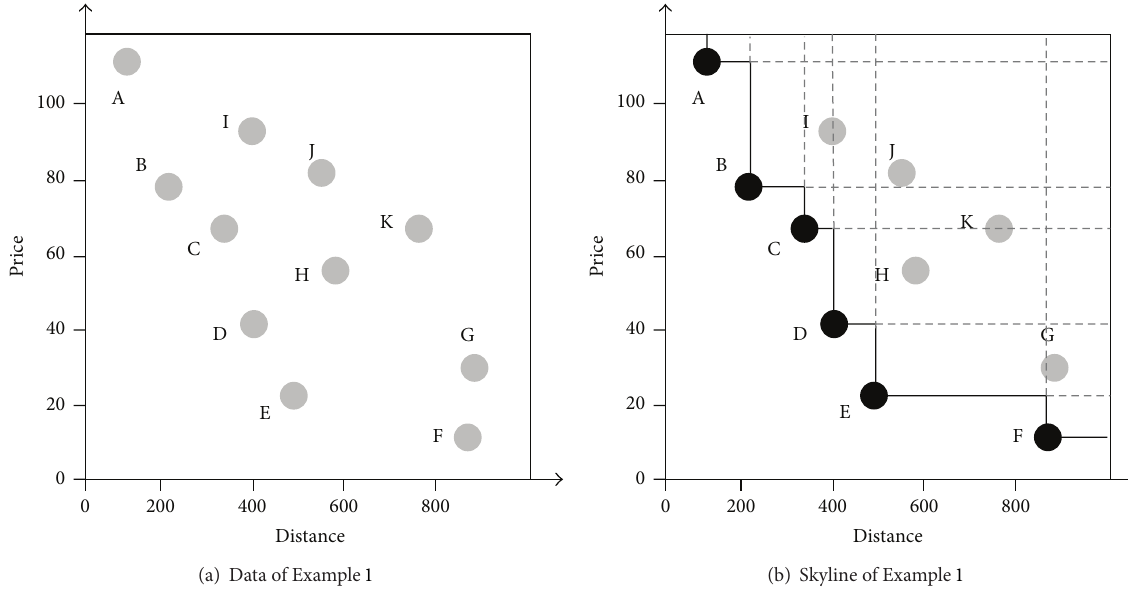
Figure 1: Graphical representation of data and skyline.